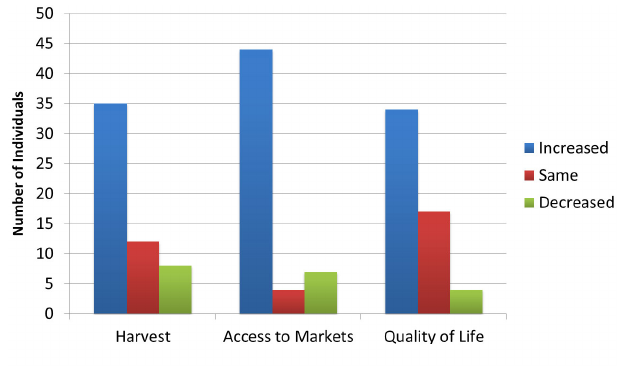
Fig. 7 . Change in economic well-being and quality of life over the previous three